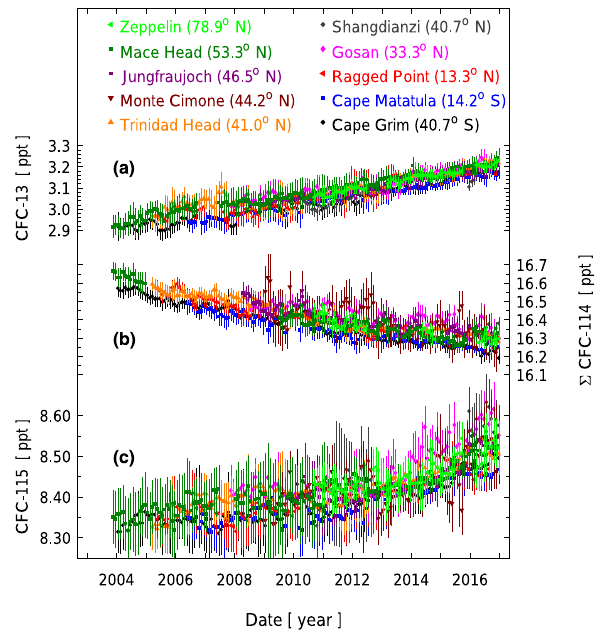
Figure 4. Abundances of the chlorofluorocarbons CFC-13 (a) , (cid:54) CFC-114 (b) , and CFC-115 (c) at stations of the AGAGE (Ad- vanced Global Atmospheric Gases Experiment) network. These in situ data are binned into monthly means after applying a pollution filter to limit the records to samples under background conditions (O’Doherty et al., 2001; Cunnold et al., 2002). Vertical bars are standard deviations of the monthly means (1 σ ). Occasional devi- ations of the Monte Cimone measurements from the other sites for (cid:54) CFC-114 and CFC-115 (CFC-13 not measured at this site) are explained by the significantly larger propagation uncertainties (par- tially caused by larger precisions) for this site compared to the other